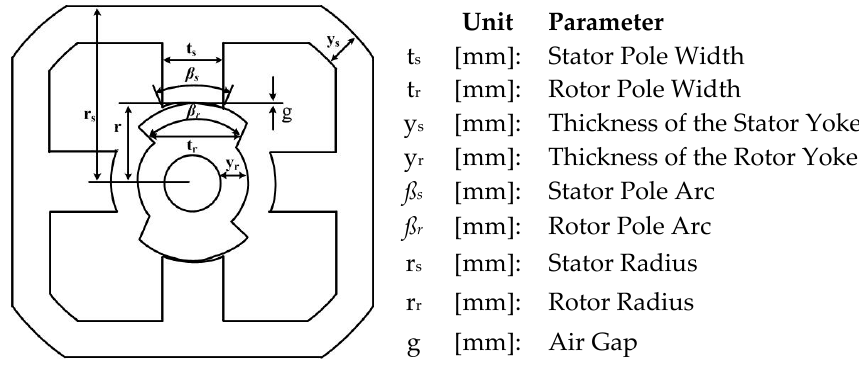
Figure 3. Design parameters of the proposed two ‐ phase 4/2 pole SRM.